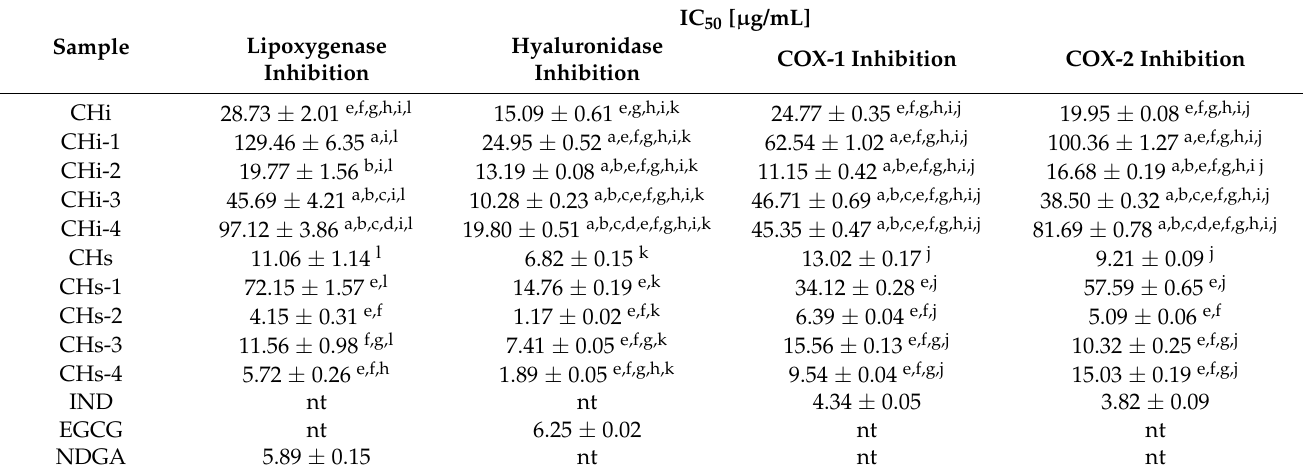
Table 7. Anti-lipoxygenase, anti-hyaluronidase, and anti-cyclooxygenase activities of the leaves of C. hissaricus and C. hsingshangensis